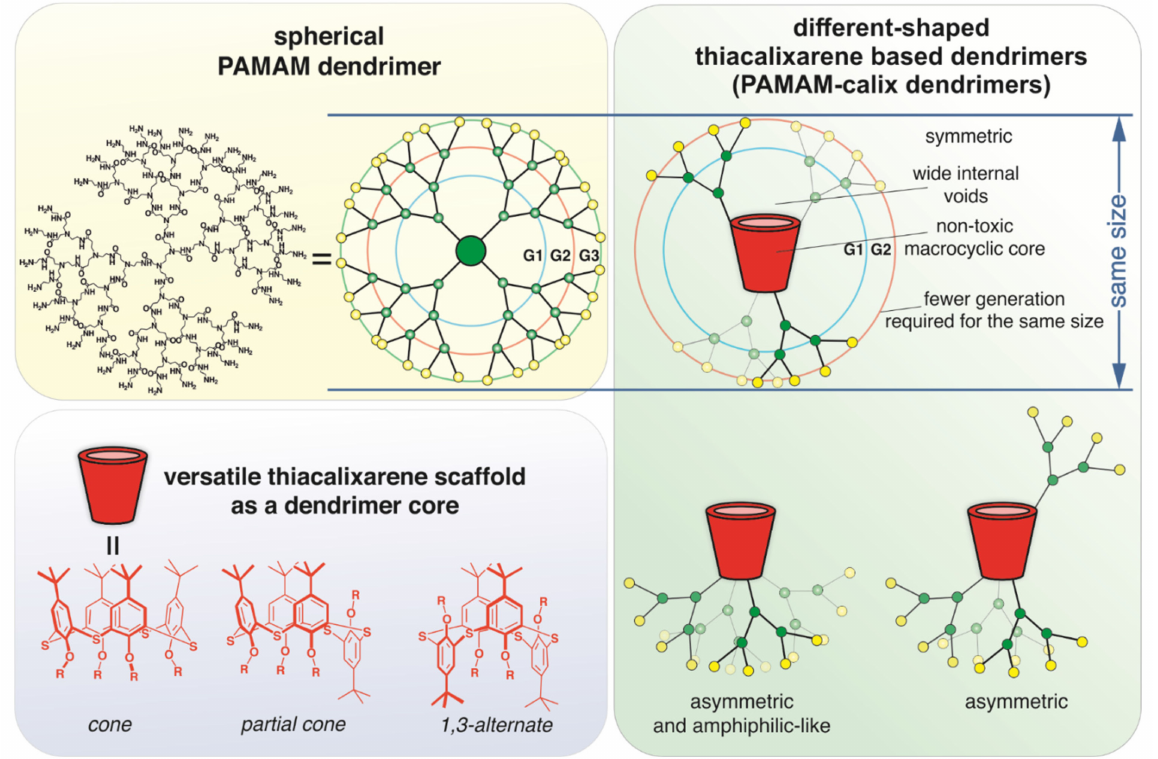
Figure 1. Schematic representation of the design of thiacalix[4]arene-based dendrimers. Previously, we established the binding of salmon sperm DNA by thiacalix[4]arene derivatives containing four amidoammonium fragments at the lower rim resulted in the formation of associates of the size within 200 nm [17]. In this work, first-generation dendrimers based on the macrocycle (PAMAM-calix-dendrimers G1 ) with a large number of binding sites (12 amide and 12 ammonium fragments) were synthesized for the first time. The interaction of the obtained compounds with DNA was studied to establish